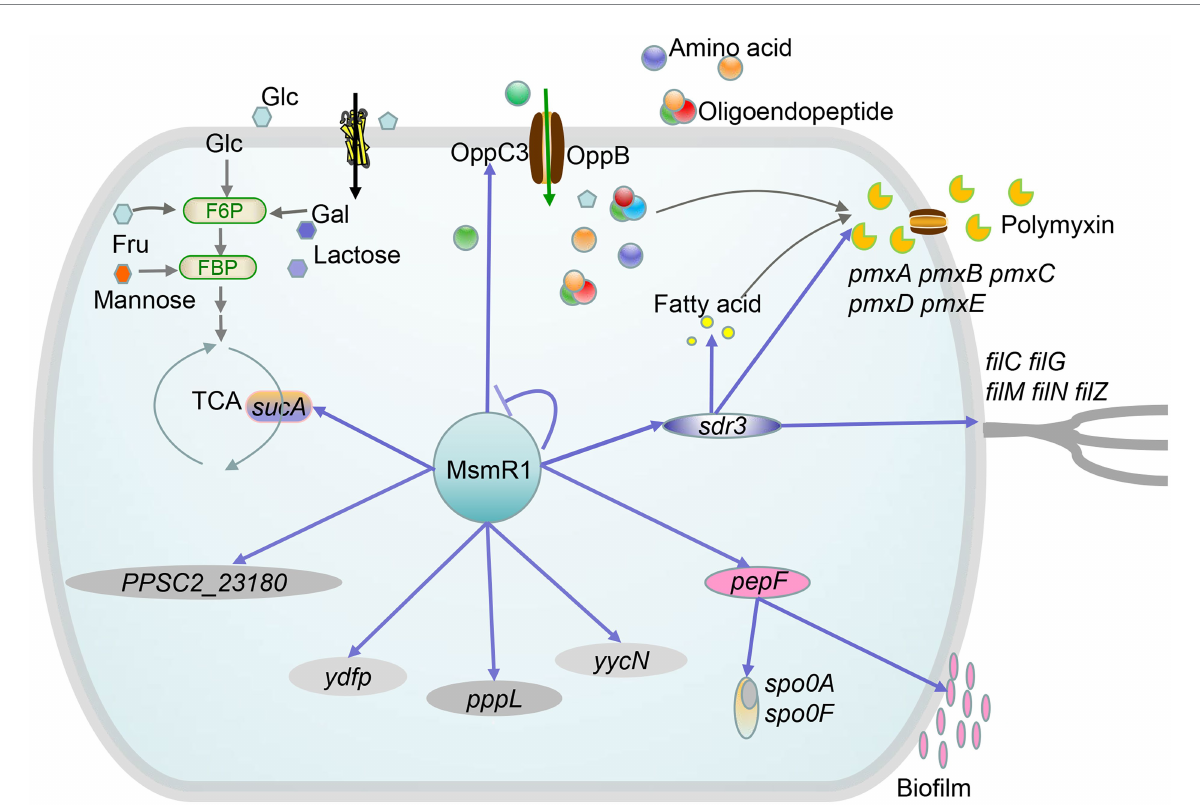
FIGURE 7 Proposed regulatory network of MsmR1 in P. polymyxa SC2. MsmR1 plays a regulatory role in the TCA cycle ( sucA ), amino acid metabolism, polymyxin synthesis ( oppC3 , sdr3 ), motility ( sdr3 ), and biofilm and spore formation ( pepF ). Blue arrows: activation; bar-ended lines: repression; green arrows: metabolism